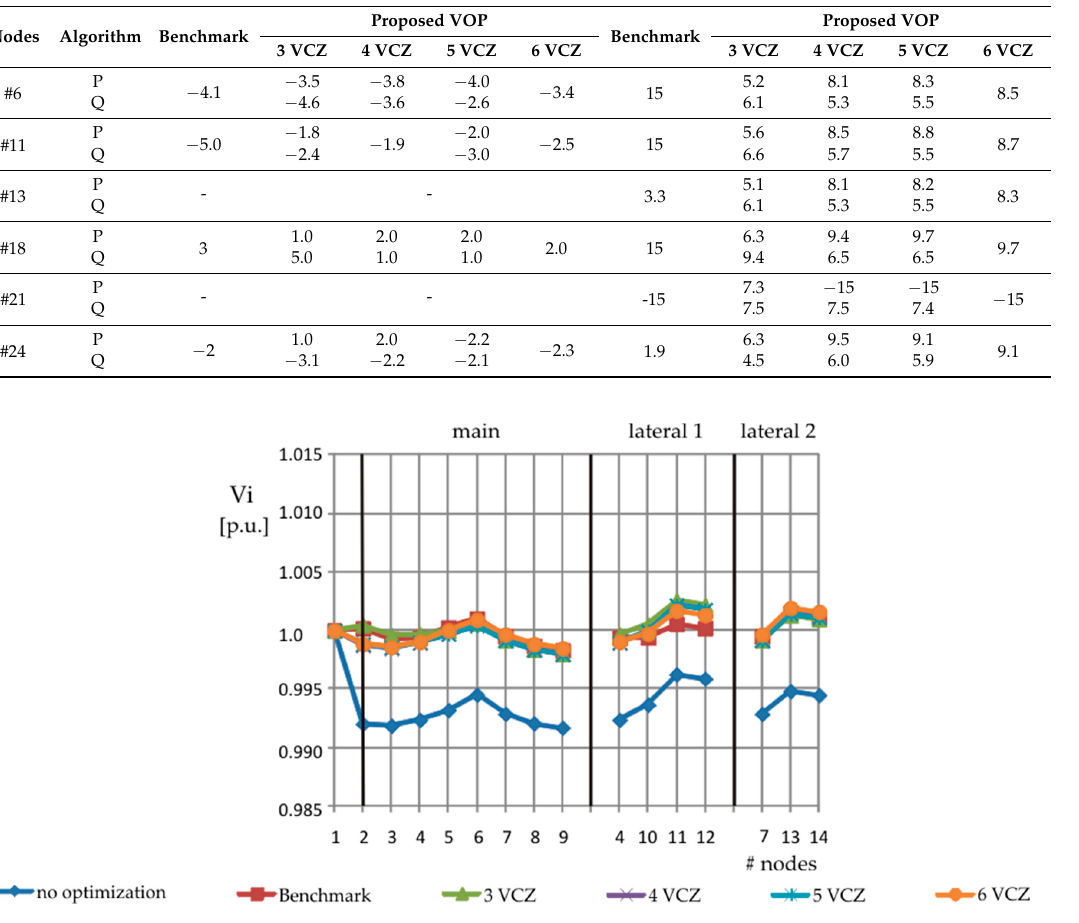
Figure 8. Voltage profiles for Case R —DG and BESS: P algorithm—feeder 1. Figure 8 : Voltage profiles for Case R — DG and BESS: P algorithm—feeder 1. Figure 8 : Voltage profiles for Case R — DG and BESS: P algorithm—feeder 1.